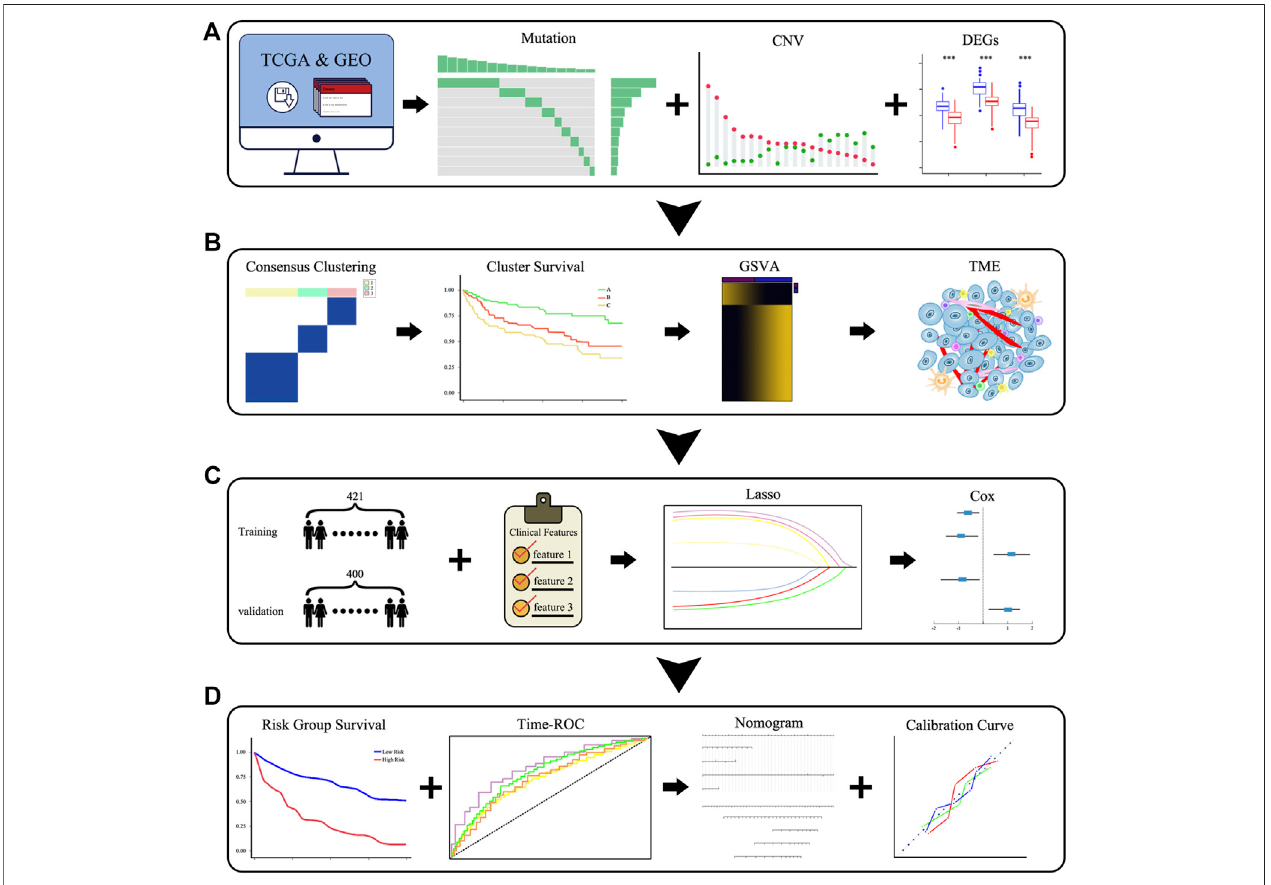
FIGURE 1 | Schematic diagram of the overall fl ow of the study. (A) The landscape of the genetic and expression variation of PRGs. (B) Identi fi cation of pyroptosis- related clusters and a comparison of the differences in the survival, biological pathways, and TME among clusters. (C,D) Identi fi cation of pyroptosis-related signatures and construction of a predictive